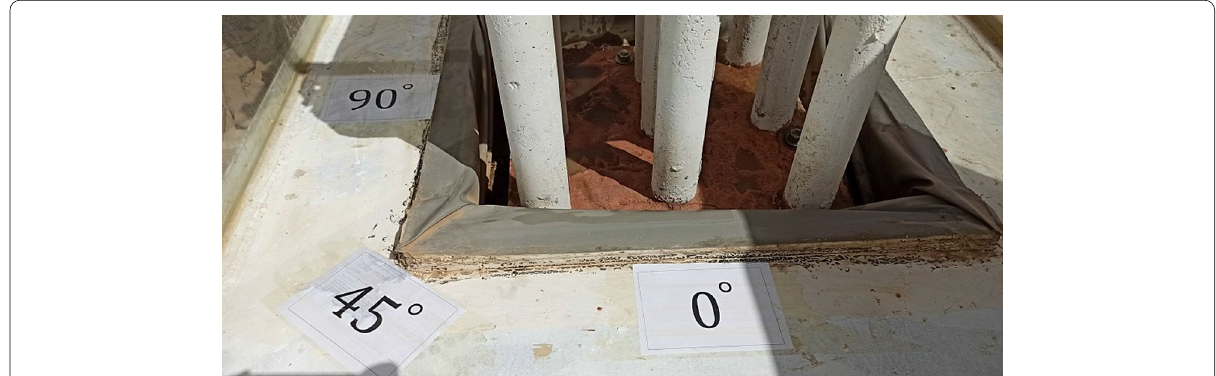
Fig. 7 Model orientation tests.